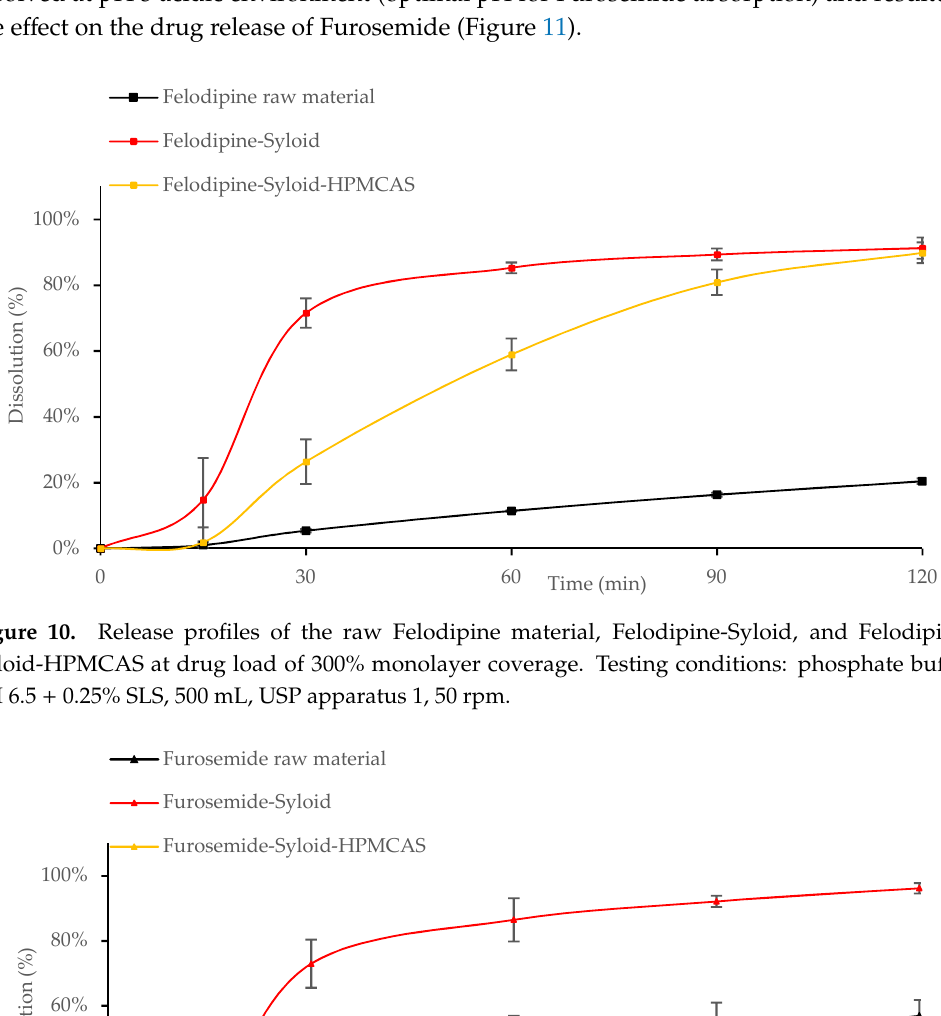
Figure 9. DSC thermograms of the raw Furosemide material and FURO-Syloid-HPMCAS at various drug loads. Scanning rate: 10 °C/min. Scanning range: 100–300 °C.